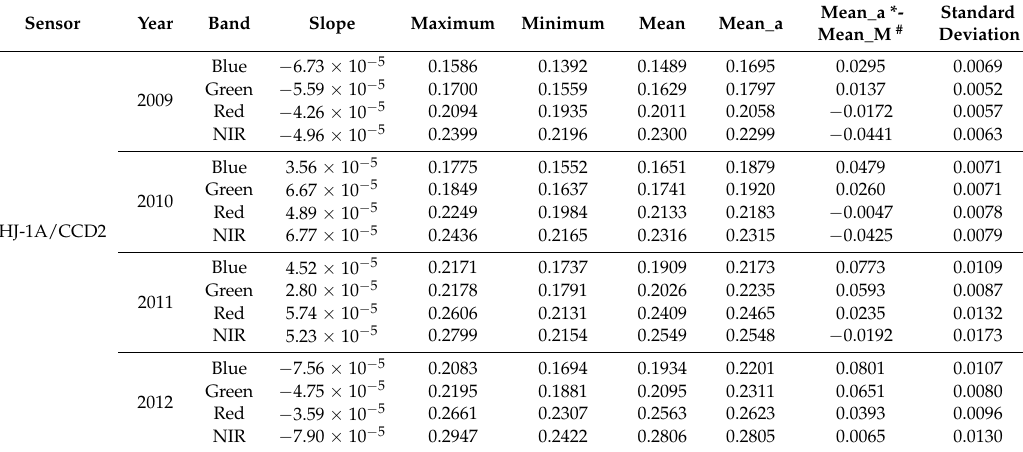
Table 9. The statistics from the time series of the TOA reflectance of HJ-1A/CCD2.